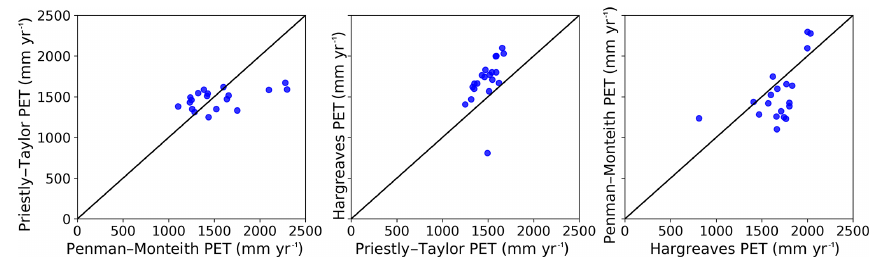
Figure 6. Comparison of the P–M, P–T and Hargreaves potential evapotranspiration products with respect to their prediction of mean PET across the